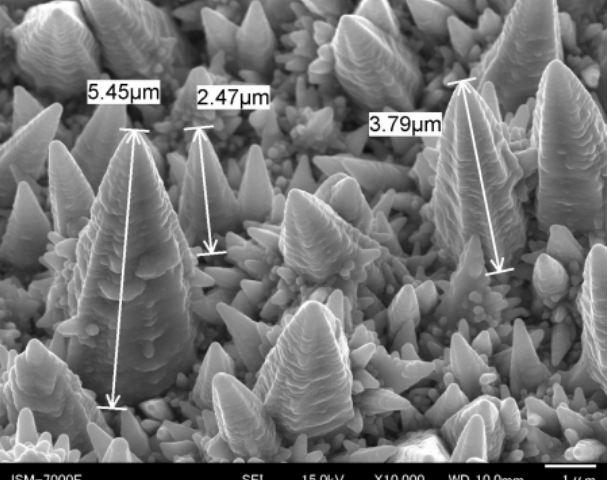
Figure 8. Local distribution of micro-cones in the LL-specimen, measured by SEM.